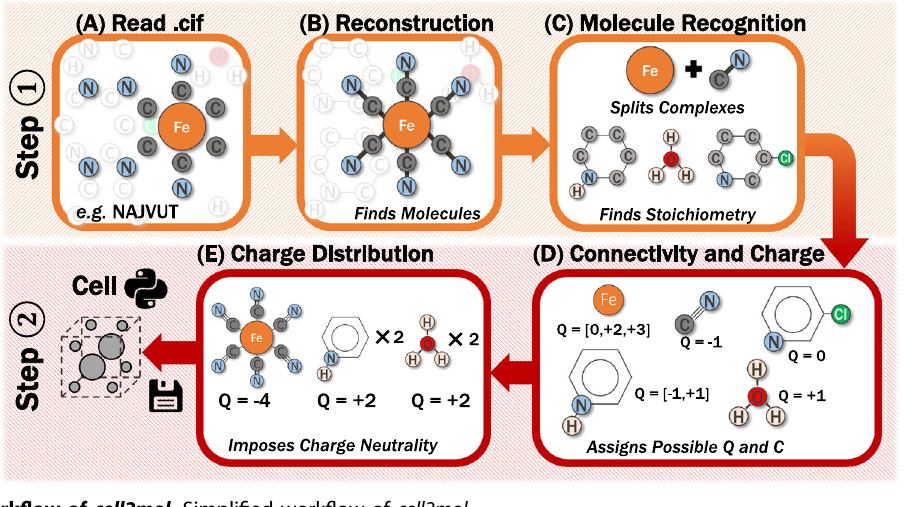
Fig. 1 Simpli fi ed work fl ow of cell2mol . Simpli fi ed work fl ow of cell2mol .